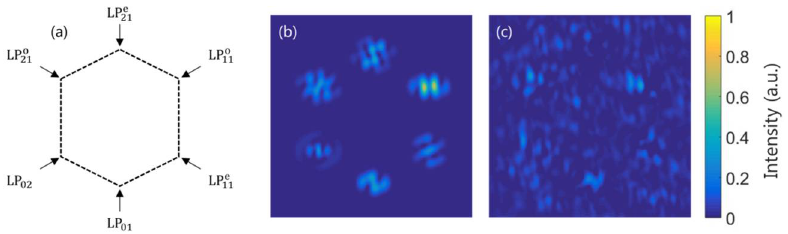
Figure 6. ( a ) Simultaneous MD spatial configuration scheme; ( b , c ) normalized transversal intensity distributions W f,S and W f,N , respectively, when all six LP-modes are equally present in the incident light.